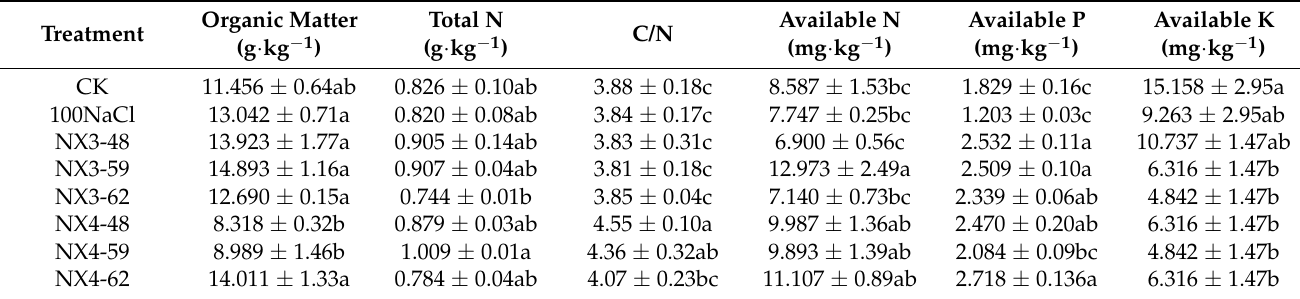
Table 2. Substrate nutrient concentration under compound inoculation treatments with different bacterial strains. Treatment